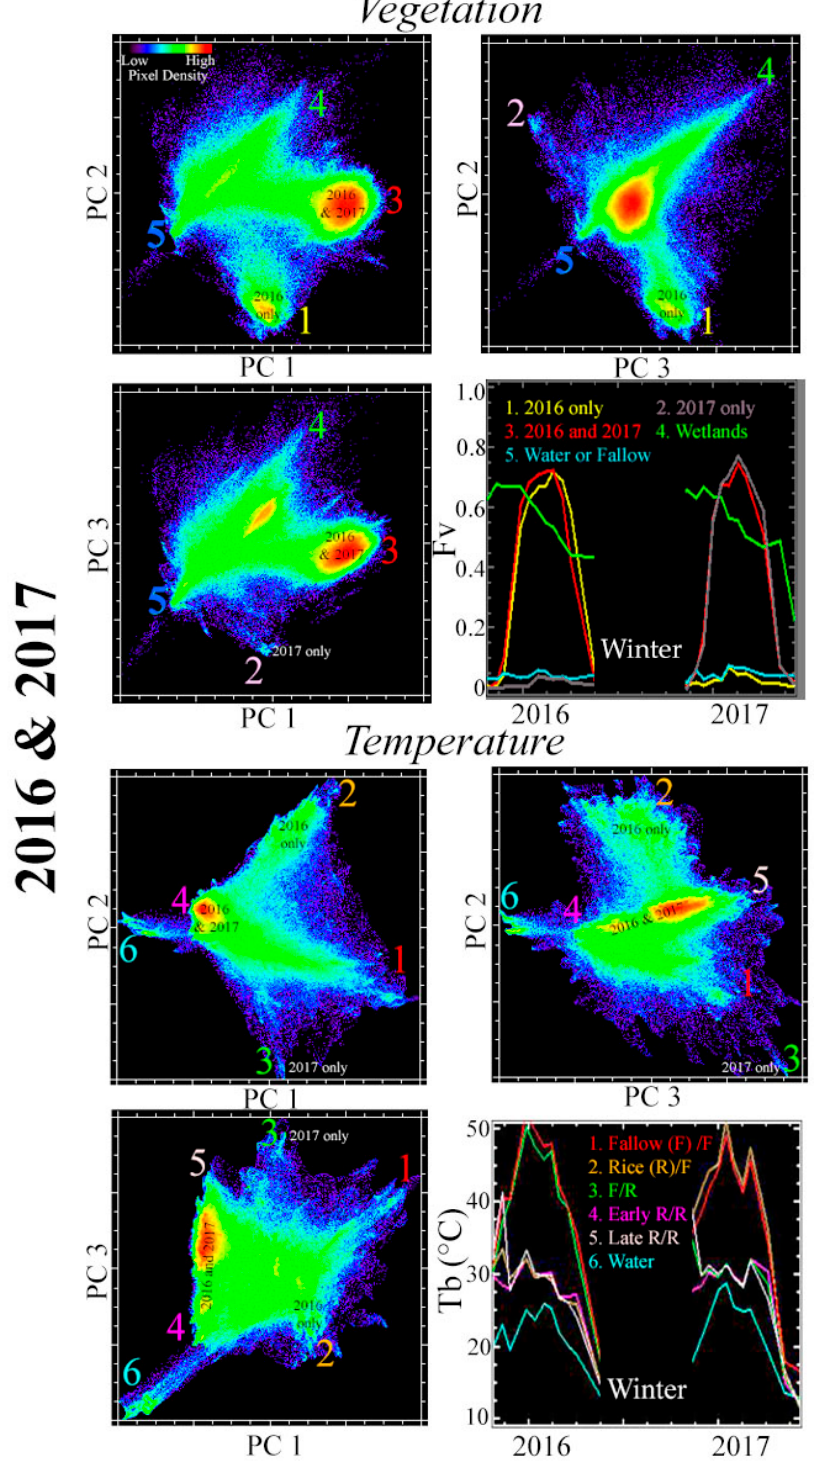
Figure 6. Joint 2016 & 2017 F v vs. LST TFS comparison. When both years are analyzed together, intra-year signals (time of planting) are nested inside inter-year signals (crop conversion). EMs for Figure 5a . F v vs LST 2016 temporal feature space (TFS) comparison. Each TFS highlights different both F v & LST clearly differentiate between fields planted only in one year vs. both years vs. neither aspects of the biogeophysical system. F v discriminates between early and late cropping, but cannot year. Again, LST shows more clustering than F v , suggesting that, for rice agriculture in this location, distinguish rice from other crops with similar timing. LST clearly distinguishes rice from other crops, a greater number of distinct spatially coherent temporal trajectories exist in LST time series than F v but misses the late season variability captured by F v . These differences are reflected in EMs. F v EMs time series. Early and late cropping remain as distinct EMs in LST, but do not in F v